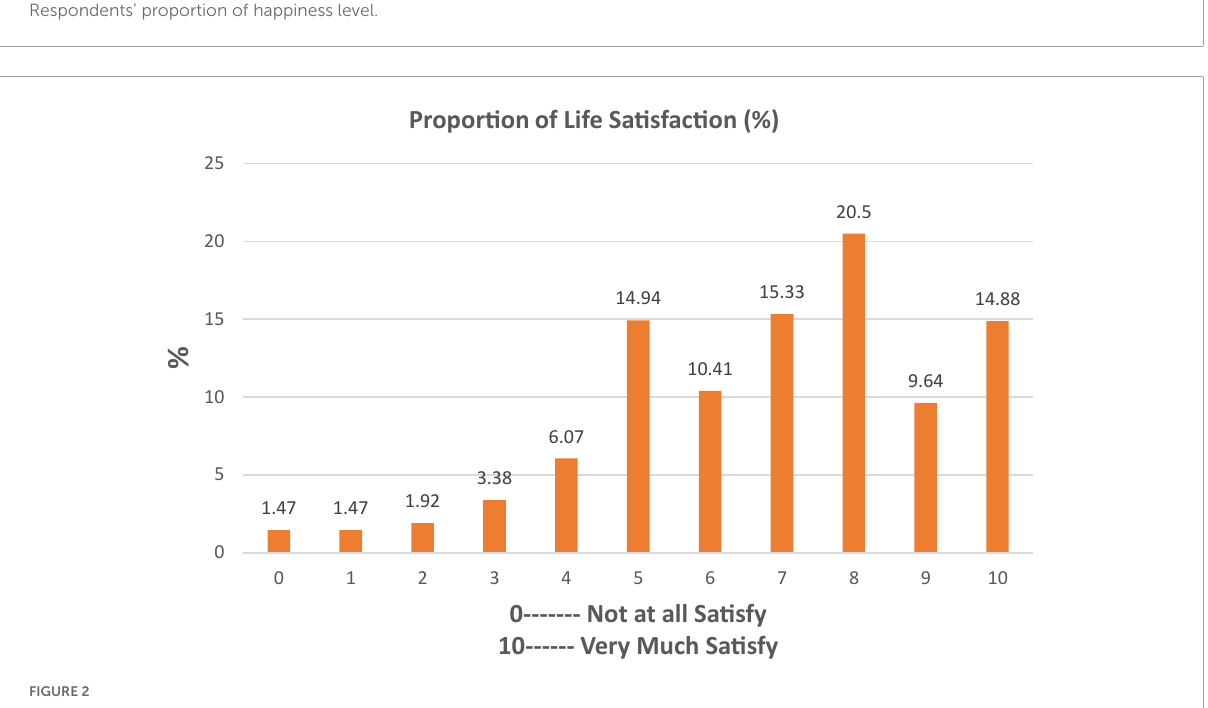
FIGURE1 Respondents’ proportion of happiness level.